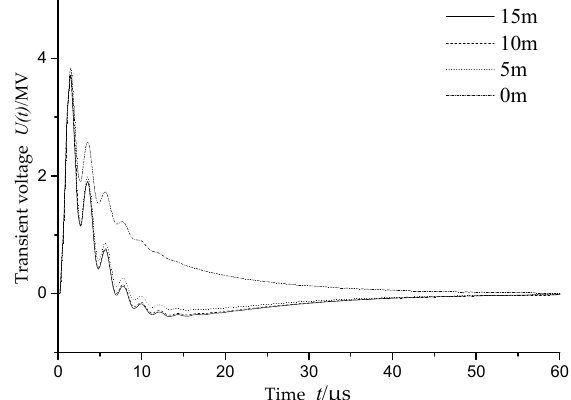
Figure 10. Effect of ocean depth on the transient potential.